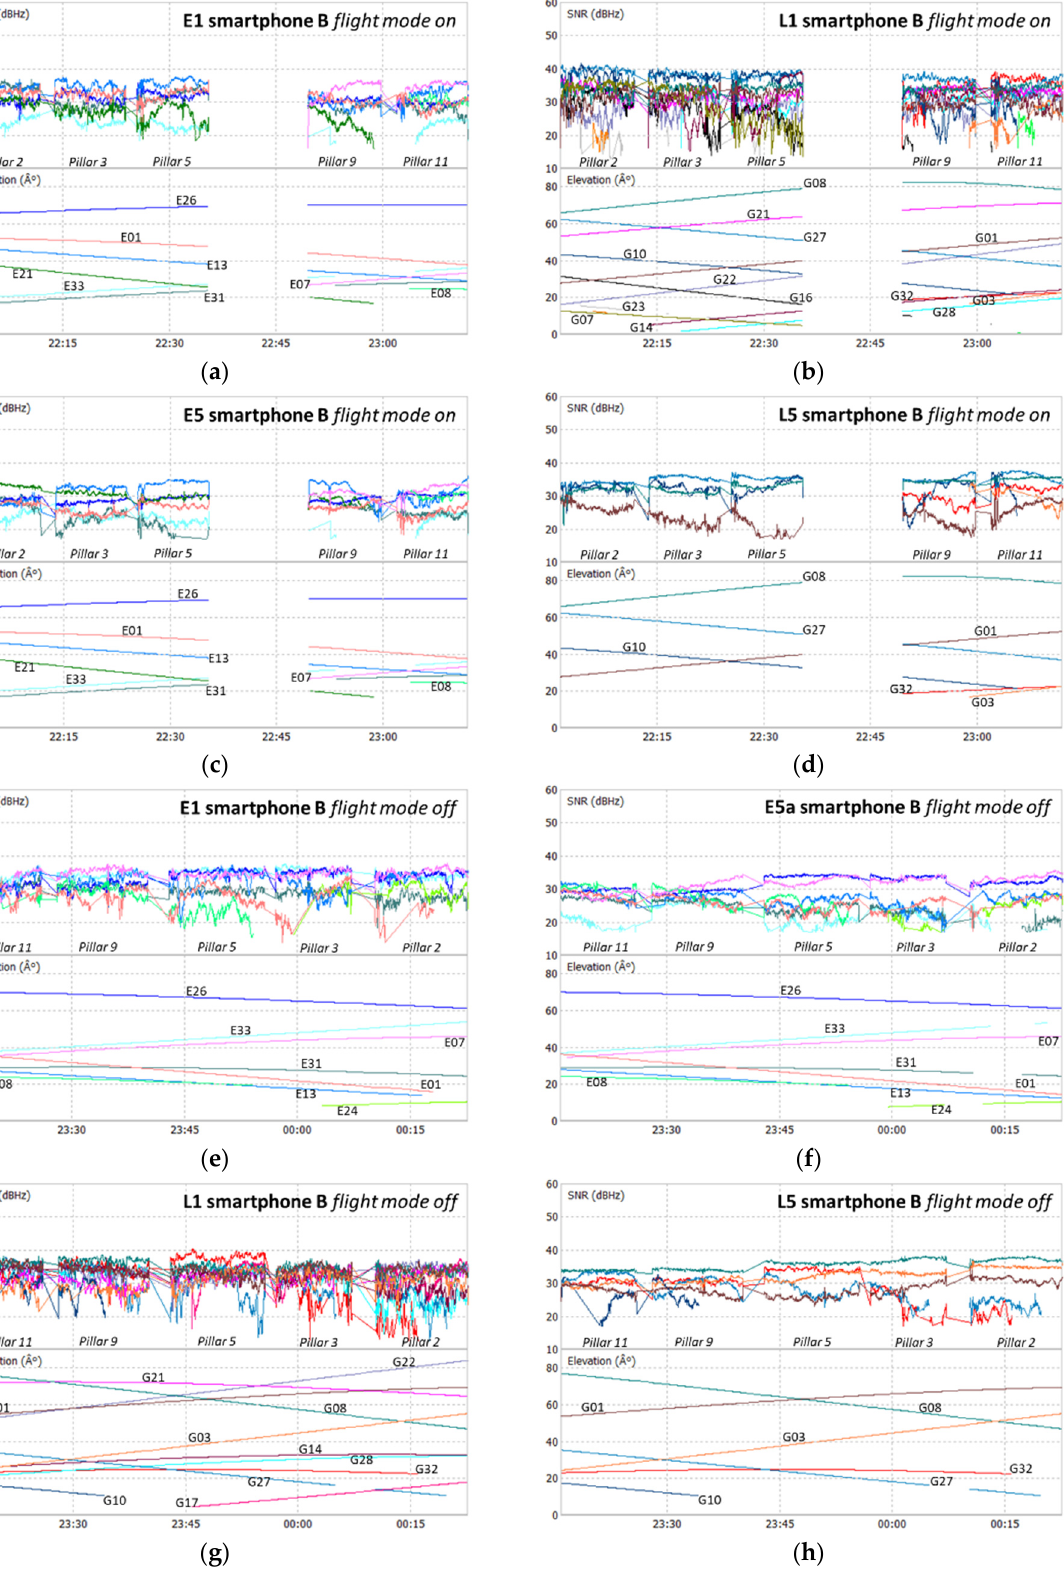
Figure 7. Test 1 SNR smartphone B: E1 flight mode on ( a ); L1 flight mode off ( b ); E5a flight mode on ( c ); L5 flight mode on ( d ); E1 flight mode off ( e ); L1 flight mode off ( f ); E5a flight mode off ( g ); L5 flight mode off ( h ).